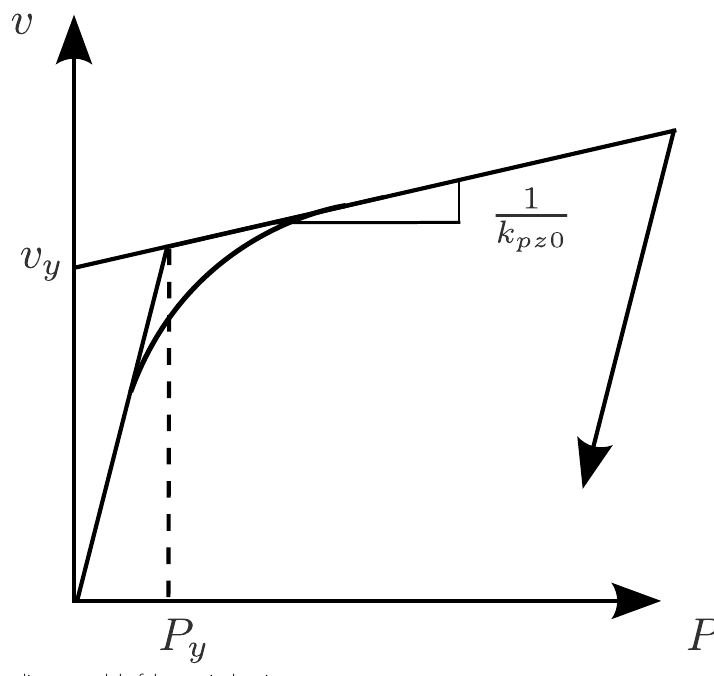
Fig. 5 Nonlinear model of the vertical spring